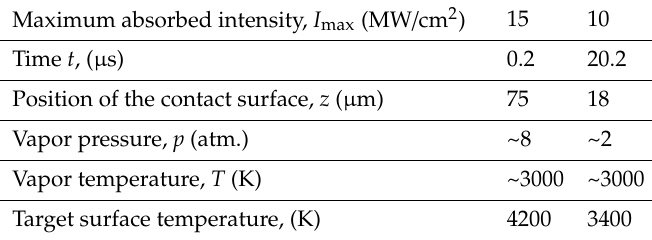
Table 4. Calculated parameters of